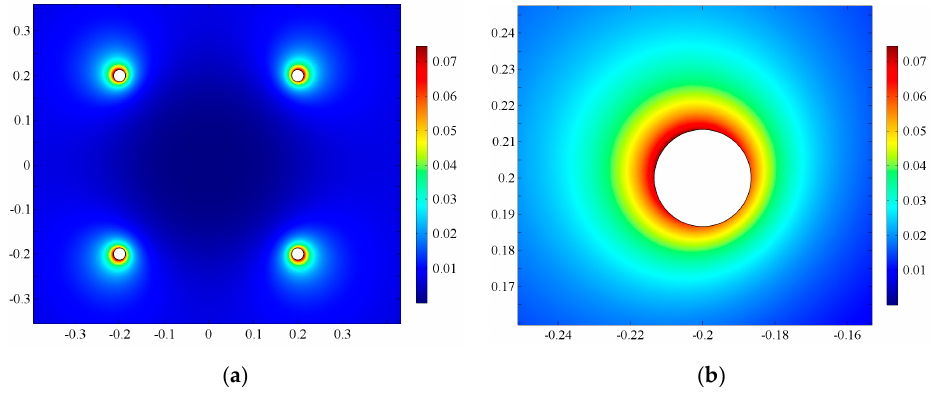
Figure 4. Electric-field distribution of conductor bundles in a corona cage. ( a ) Contour surface of electric field (kV/m); ( b ) enlarged contour surface of electric field (kV/m) (upper-left conductor).